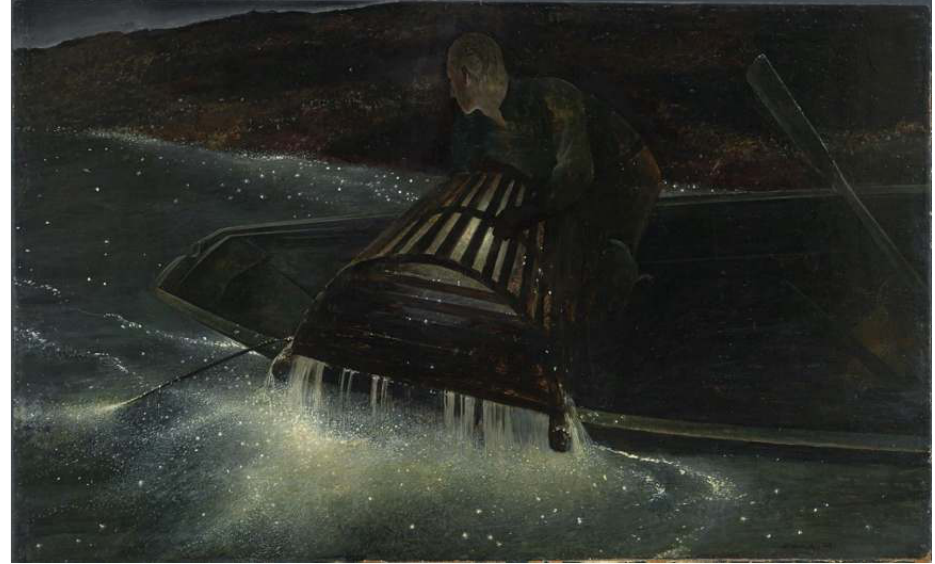
Figure 10. Andrew Wyeth. Night Hauling . Tempera on masonite